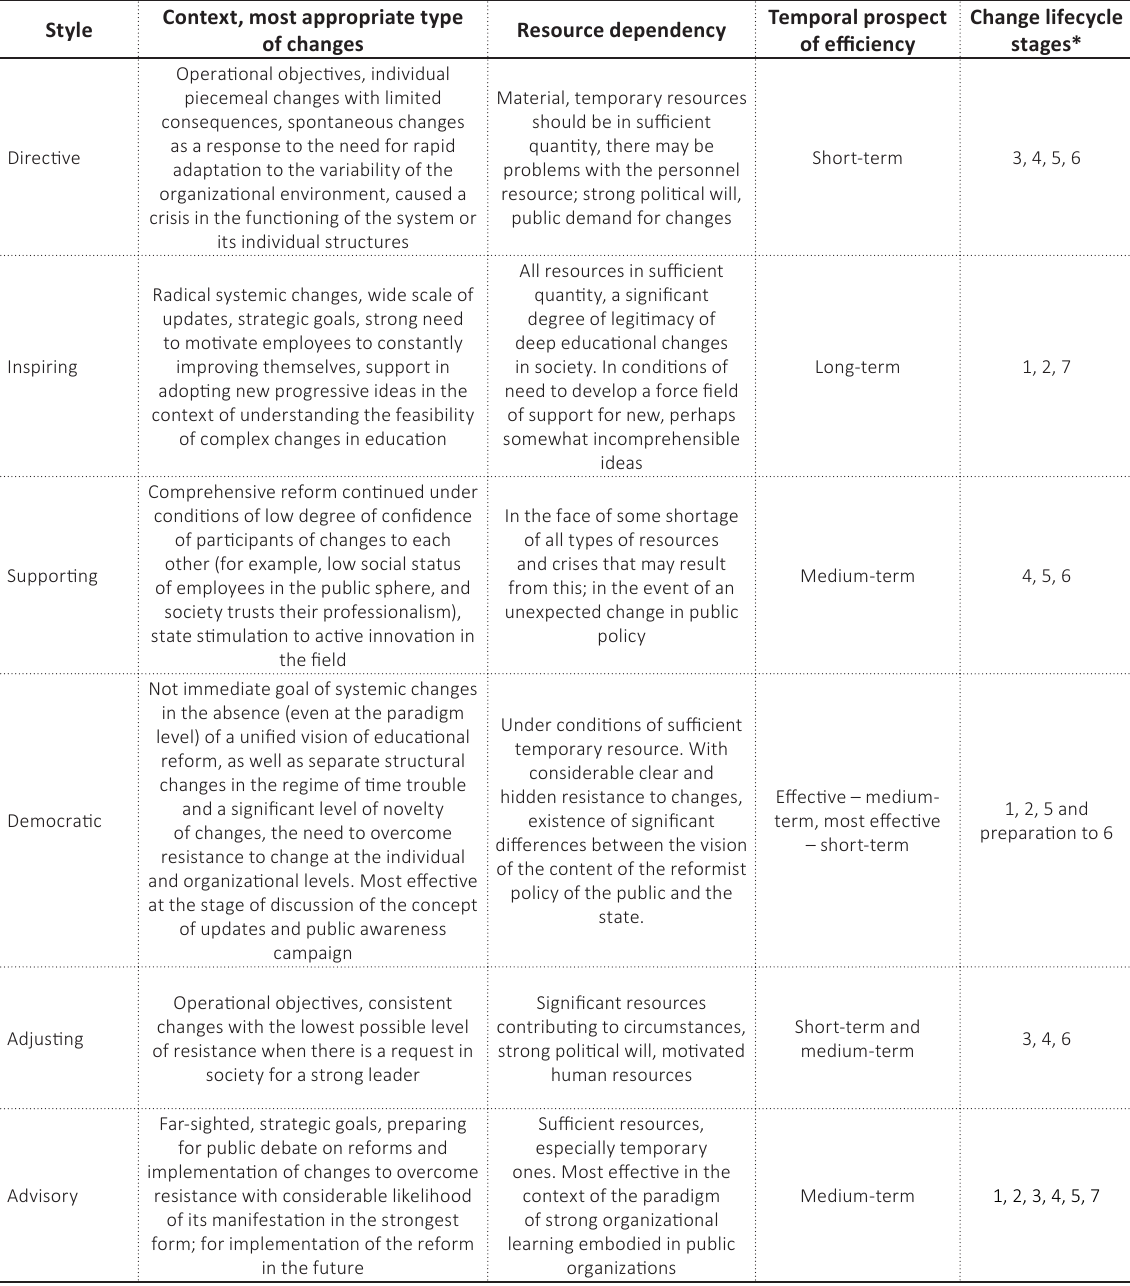
Table 6. Dependence of leadership styles on the context of the implementation of organizational